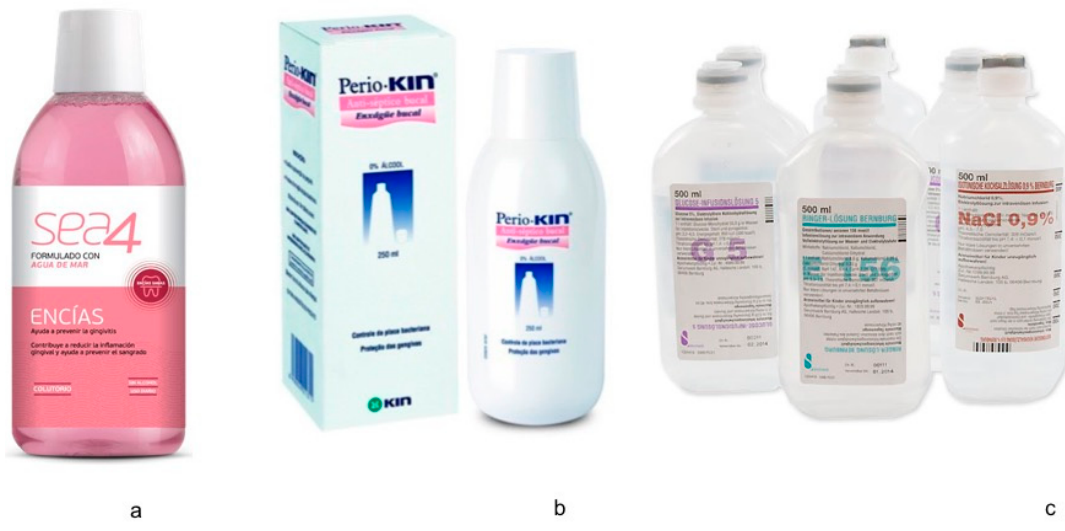
Figure 2. The mouth rinses used in the study: ( a ) Bottle A (Sea4), ( b ) Bottle B (PerioKin CHX 0.20%), and ( c ) Bottle C (saline).